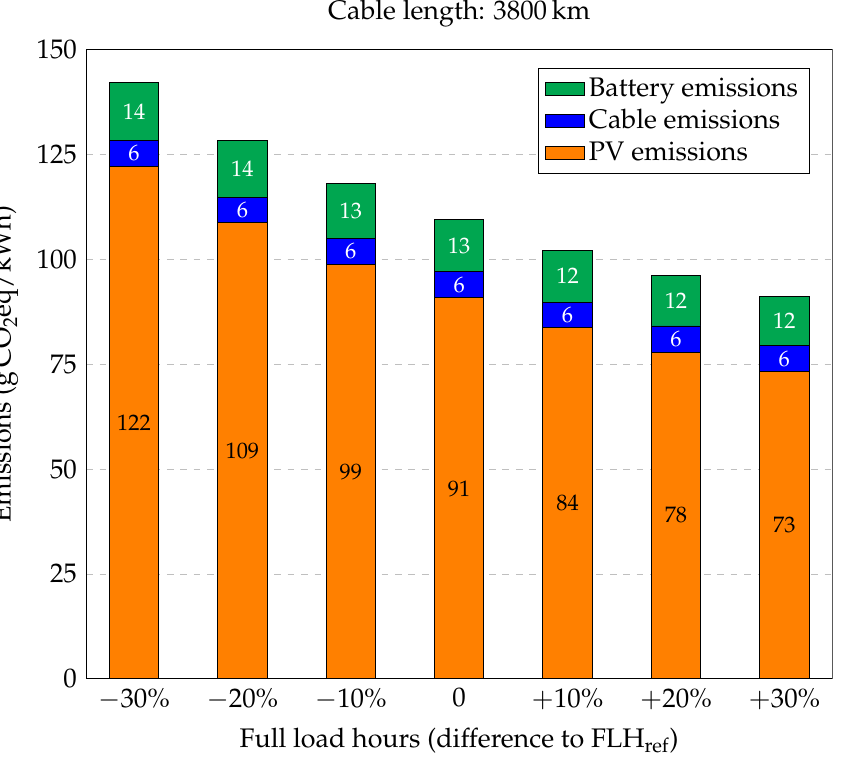
Figure 4. Emissions from production of the battery system, PV installation, and cable per kWh of electricity generated for different numbers of full-load hours and a cable length of